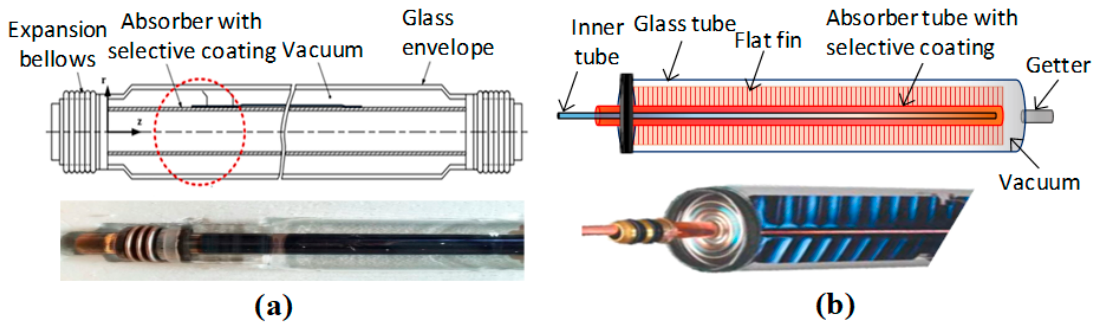
Figure 1. Evacuated tube receiver with: ( a ) single flow through tube (SFT) absorber; ( b ) concentric tube (CT) absorber with flat fins.